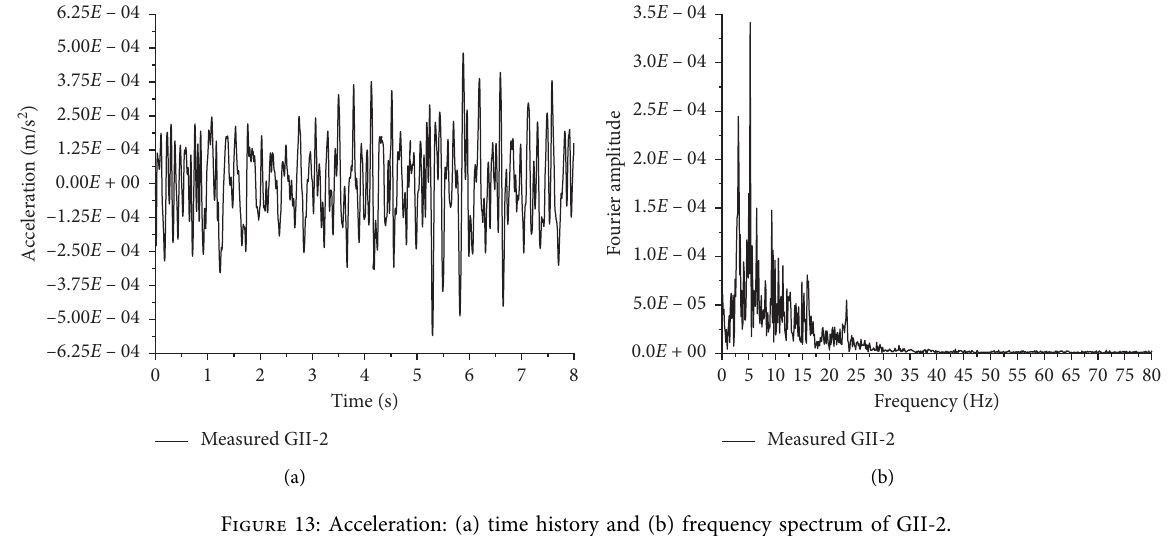
Figure 13: Acceleration: (a) time history and (b) frequency spectrum of GII-2.